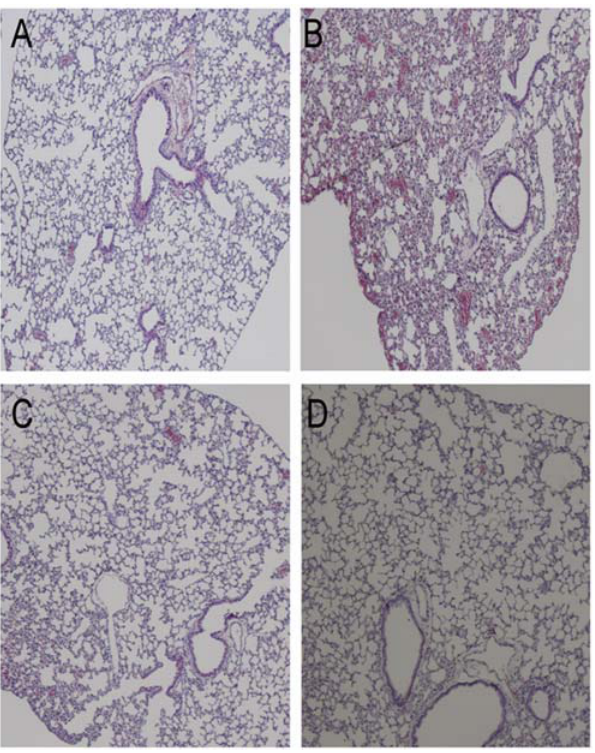
Figure 4. Histopathology of lung tissue in passively treated mice. Photomicrographs of hematoxylin and eosin stained lung sections of mice treated with single or double doses of the combination of mAbs after post experimental viral infection with Clade 1 A/Vietnam/ 1203/2004 H5N1 virus at 6 days post challenge. A) Normal morphology seen in uninfected mice, B) infected and untreated mice, C) mice treated with a single dose of 5 mg/kg of ch-mAbs at 24 h post infection, D) mice treated with two doses of 5 mg/kg of ch-mAbs at 24 h and 72 h post infection.